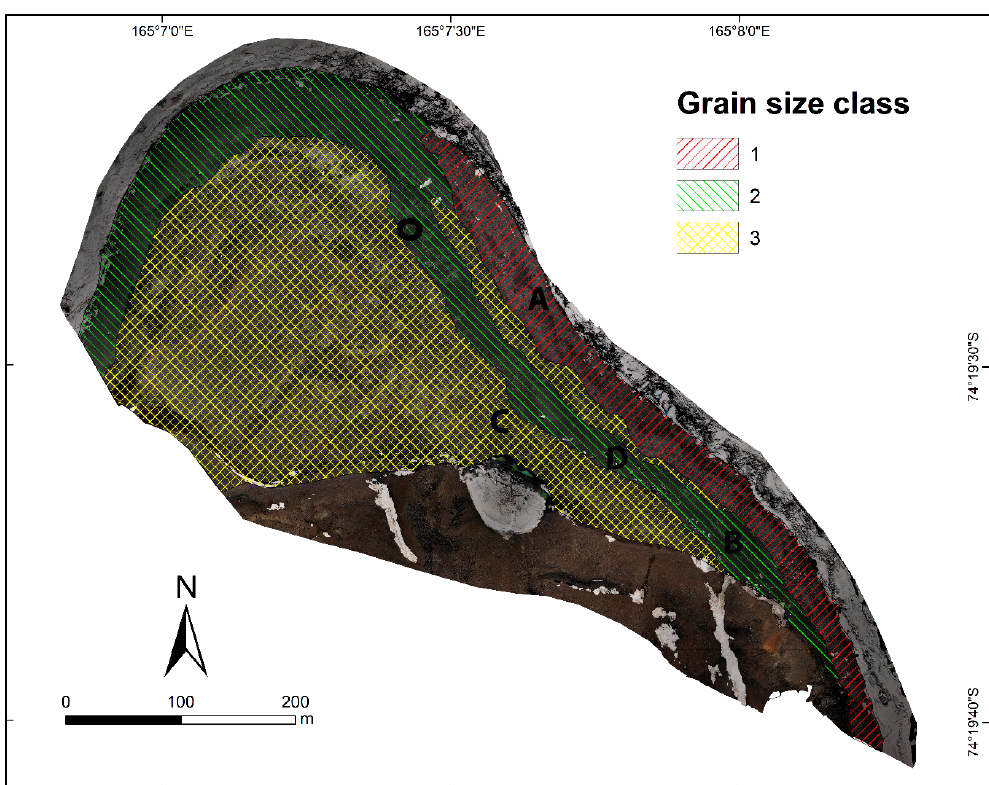
Figure 4. Distribution of the grain size classes at EPNB: (1) pebbles dominated, (2) sand dominated, (3) pebbles and boulders embedded in sandy matrix. Letters (A, B, C, D) refer to the location of the ground images showed in Figure 3, while the black circle refers to the location of the SIB showed in the Section 4.1.